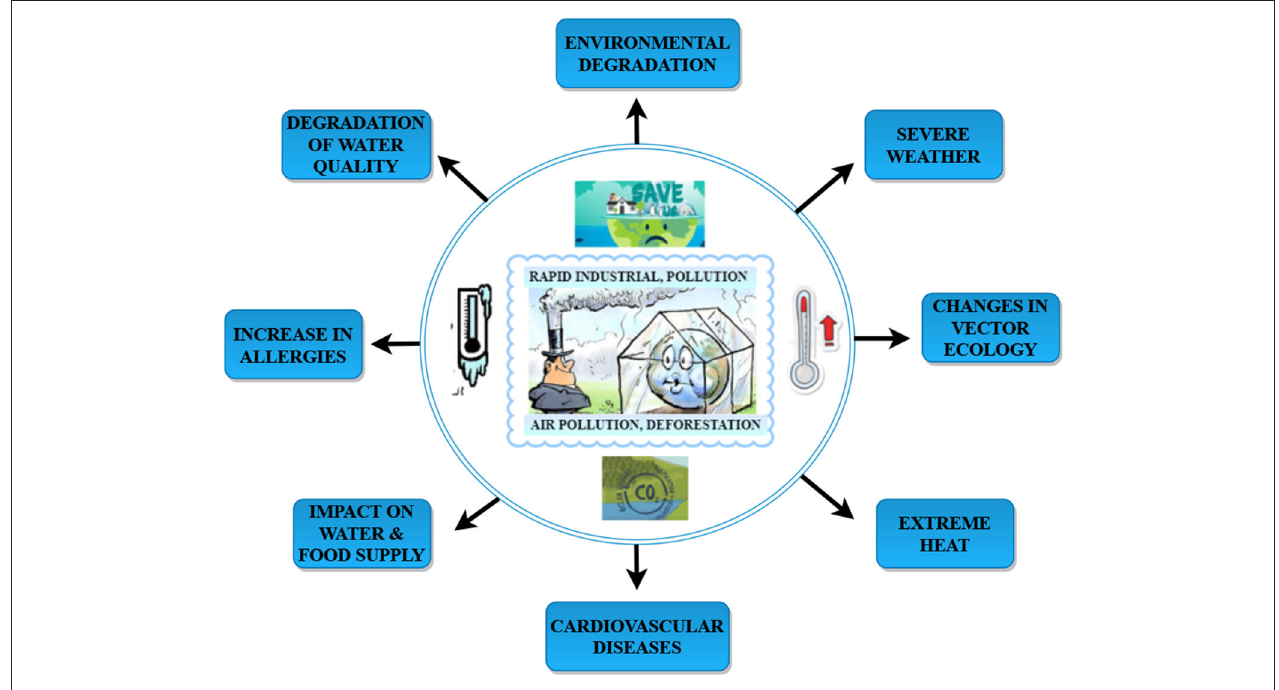
FIGURE 2 | Causes and consequences of climate